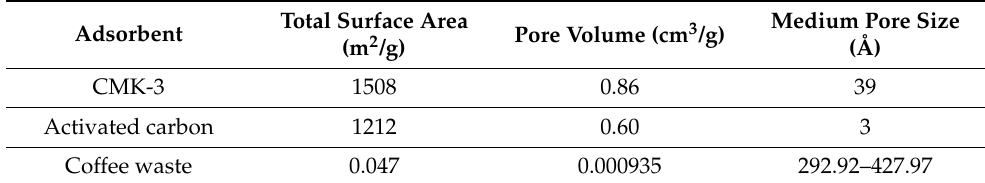
Table 9. Structural characteristics of coffee waste, activated carbon and CMK-3. Own compilation based on literature data